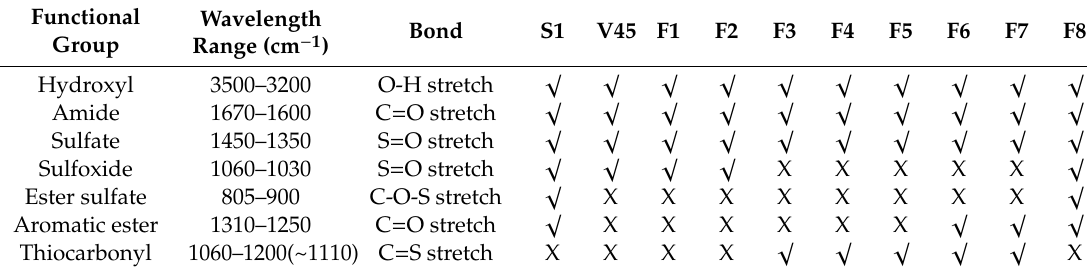
Table 2. Summary of the FTIR spectral